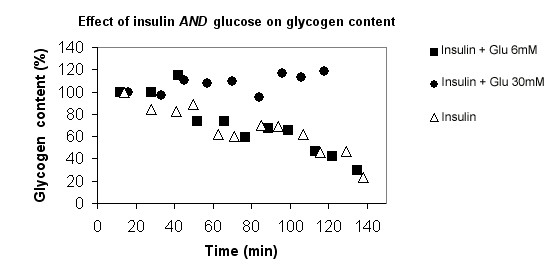
Time course of the change in hepatic glycogen content throughout the entire protocol perfusion in presence of insulin. The results are presented for three typical individual experiments: insulin alone (group D), insulin + 6 mM glucose (group E) and insulin + 30 mM glucose (group F). The results are expressed as the percentage of initial glycogen content, 100% being the value at the onset of the experiment. Note that the decrease in glycogen content observed with insulin alone was similar to that in the KHB control group.